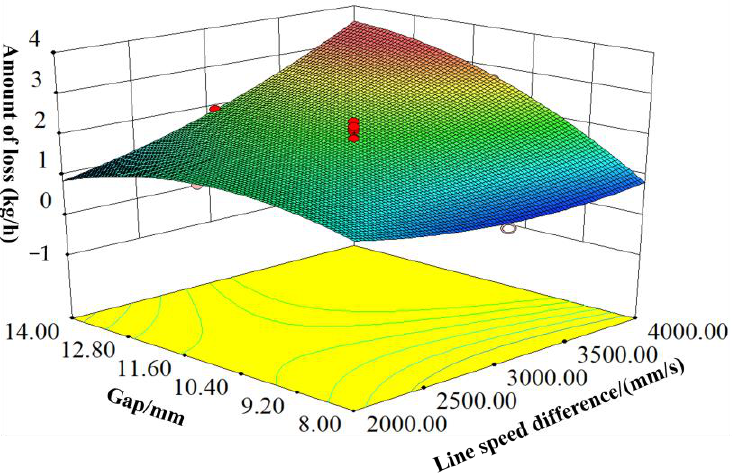
Figure 13. Influence of the gap and linear velocity difference on the amount of loss.